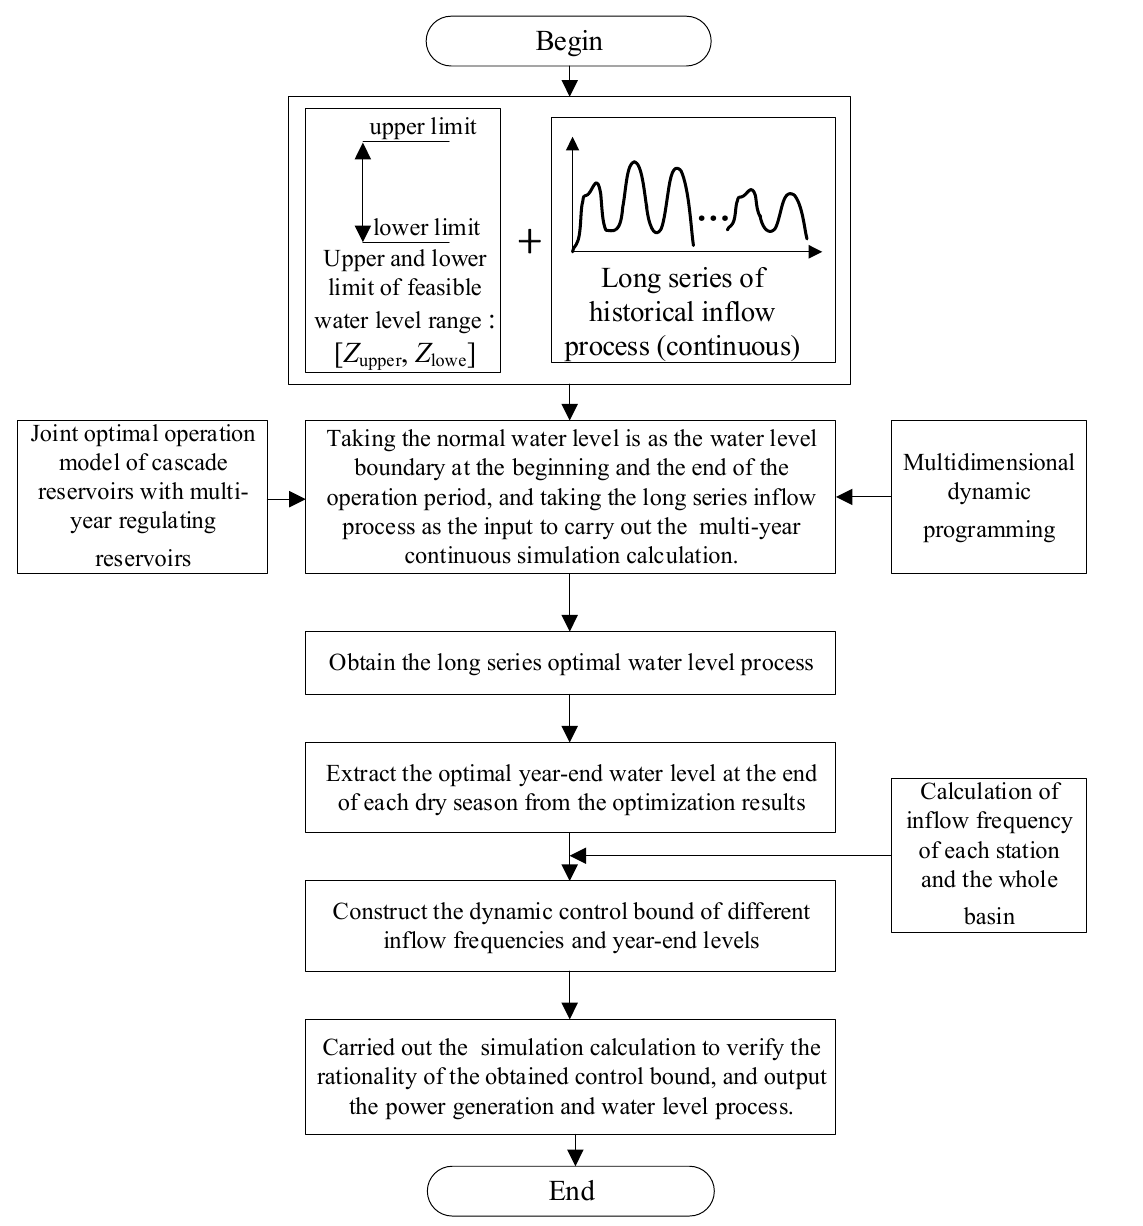
Figure 3. Optimal control scheme of yearly drawdown level of overyear regulation reservoir: dynamic control bound model.